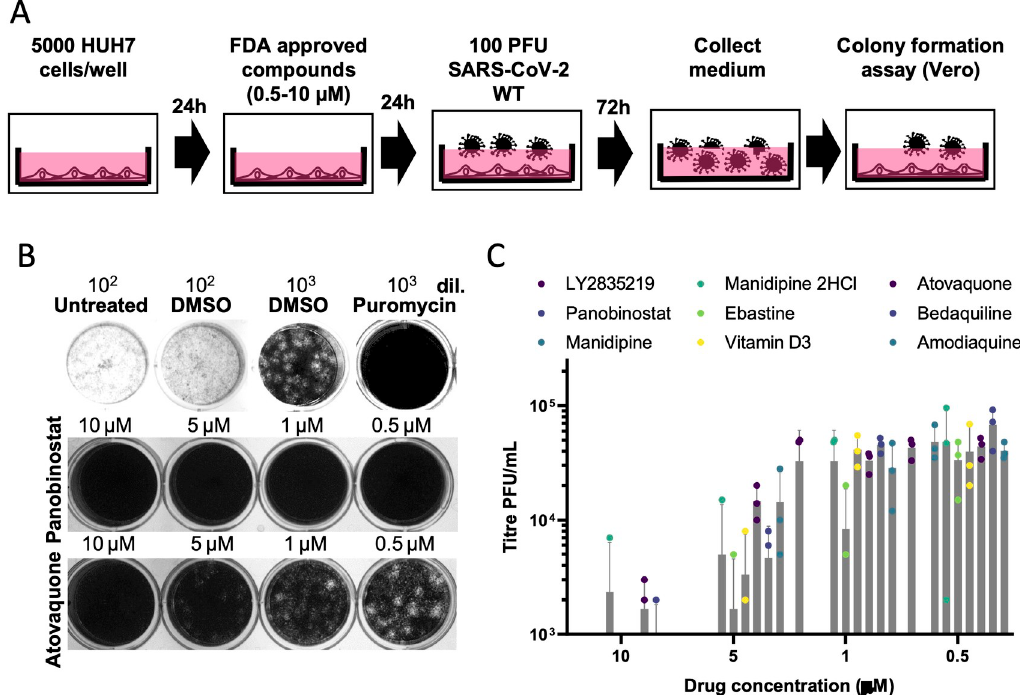
Fig 6. Effect of inhibitors on wild-type SARS-CoV-2 replication. A) SARS-CoV-2 replication in HUH7 cells treated with identified inhibitors was assessed by titering virus-containing medium. B) Example plaques obtained using medium from control (untreated or DMSO treated) or treated cultures of HUH7 cells infected with wild-type 100 PFU SARS-CoV-2. Medium was diluted 1000-fold to assess numbers of plaque forming units in treated samples. C) Wild-type virus titers from HUH7 cells treated with varying doses of the 9 compound hits. N = 3 independent repeats are shown, error bars represent the standard